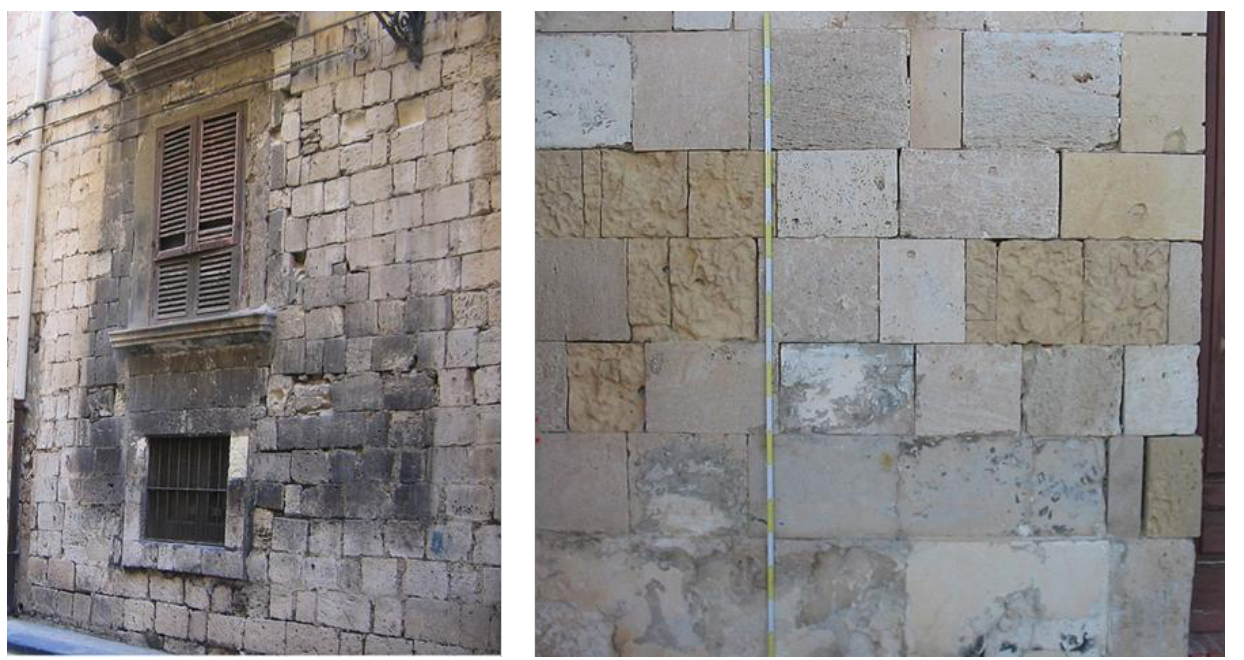
Figure 10. Two examples of historic façades of Syracuse.